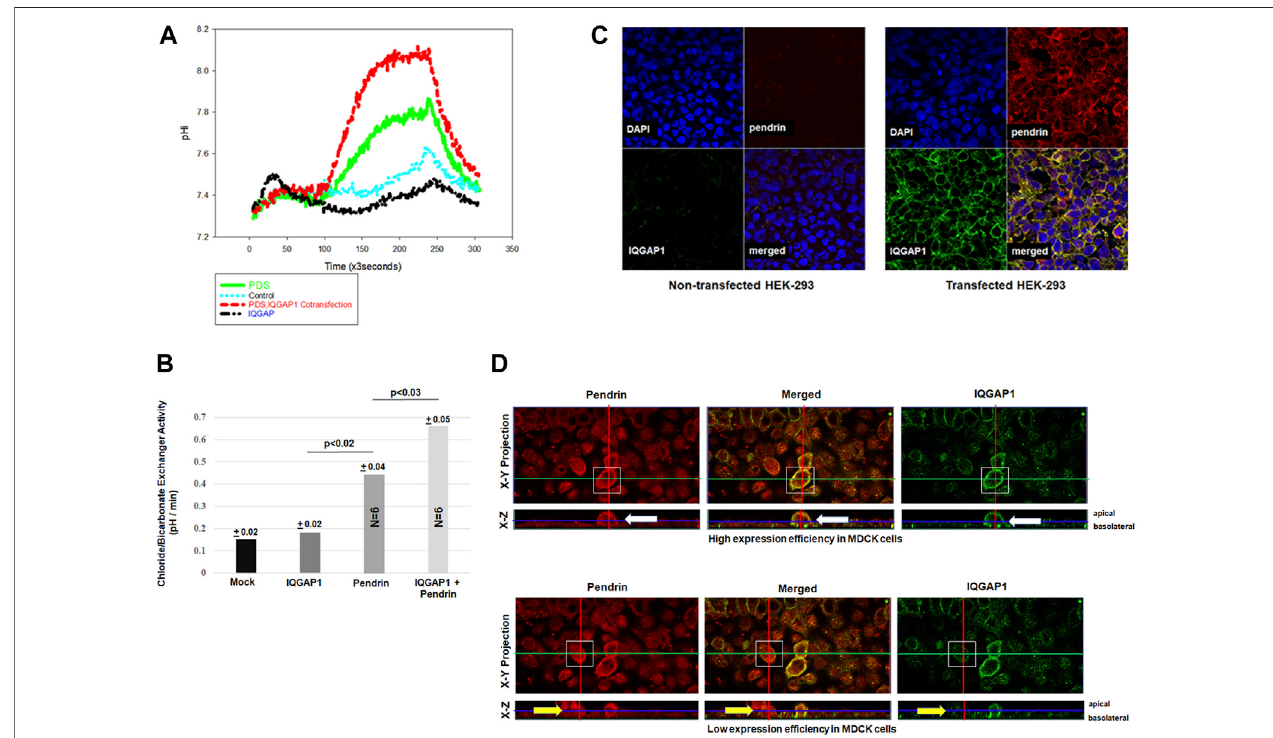
FIGURE 4 | Effect of IQGAP1 on pendrin activity and expression in cultured cells. (A) Representative tracing demonstrating the Cl − /HCO 3 − exchanger activity in transfectedHEK293cells.Themocktransfected HEK293cellswerenotsigni fi cantlydifferentvs.IQGAP1transfectedcells.ThepH i tracingsinHEK293cellstransfected with pendrin alone show signi fi cant Cl − /HCO 3 − exchanger activity compared to mock or IQGAP1 only transfected cells. HEK293 cells co-transfected with pendrin and IQGAP1 show signi fi cant enhancement in Cl − /HCO 3 − exchanger activity vs. pendrin-transfected cells. (B) The summary of six separate experiments show signi fi cantenhancementinpendrin-mediatedCl − /HCO 3 − exchangeractivityincellsco-transfectedwithpendrinandIQGAP1vs.pendrinalonetransfectedcells.IQGAP1 transfection in cells did not elicit any Cl − /HCO 3 − exchanger activity when compared to mock transfected. (C) Representative confocal images of HEK293 cells transfected with IQGAP1, pendrin or IQGAP1 plus pendrin construct. Non-transfected cells ( C ; left top and bottom panels of non-transfected groups) did not show any expressionofeitherpendrinorIQGAP1.HEK293cellsco-transfectedwithSLC26A4andIQGAP1( C ;righttopandbottompanelsoftransfectedgroups)showsharpco- localization of the two molecules on the plasma membrane of transfected cells ( C ; merged panel of transfected groups). (D) Representative confocal images of pendrin localization in high ( D ; upper panels) and low ( D ; bottom panels) IQGAP1-expressing MDCK cells. Both X-Y and X-Z projections are provided. White boxes highlight the cellsthatwereanalyzed.CellswithanelevatedexpressionofIQGAP1( D ;toprightandleftpanels,whitearrow)haveincreasedpendrinlocalizationtothecellmembrane. Whereas, low expression of IQGAP1 is associated with reduced membrane and increased intracellular localization of pendrin ( D ; bottom right and left panels, yellow